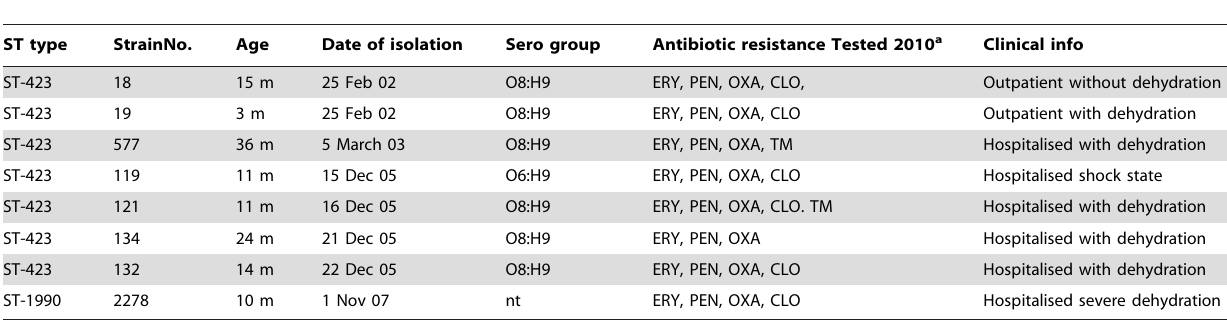
Table 3. ST-423 strains and isolate 2278 organised with respect to time of isolation, antibiotic resistance pattern and clinical data.